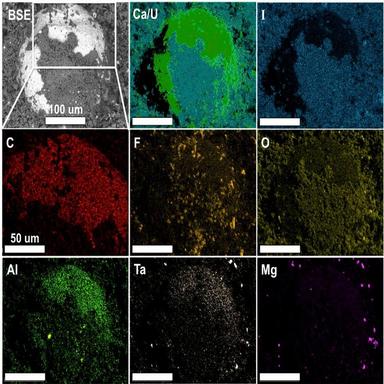
Image and elemental X-ray maps of a second U spheroid. A Ta map shows that it is concentrated at various spots on the U surface.